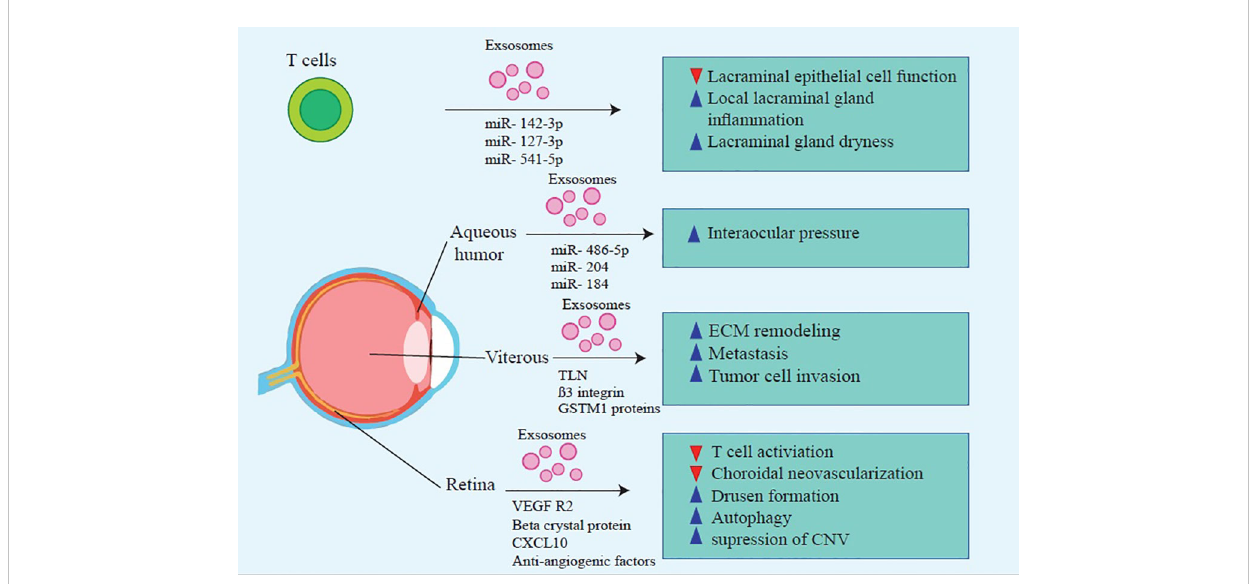
FIGURE 1 Molecular mechanisms that contribute to MSC-Exos ’ bene fi cial effects on treating in fl ammatory ocular